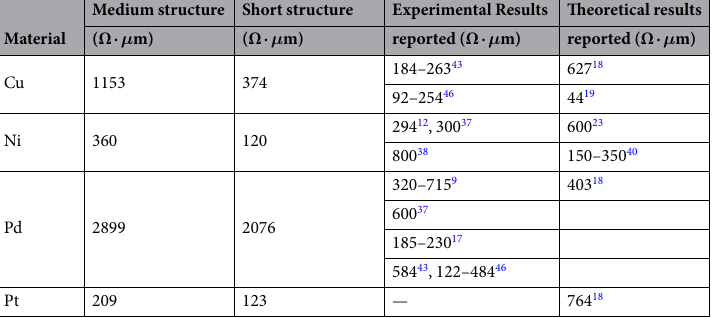
Table 2. Contact resistance per unit width ( R c ). For different metals, we compare results of our simulations for the medium (point A) and short (point B) structures, with experimental and theoretical results from the